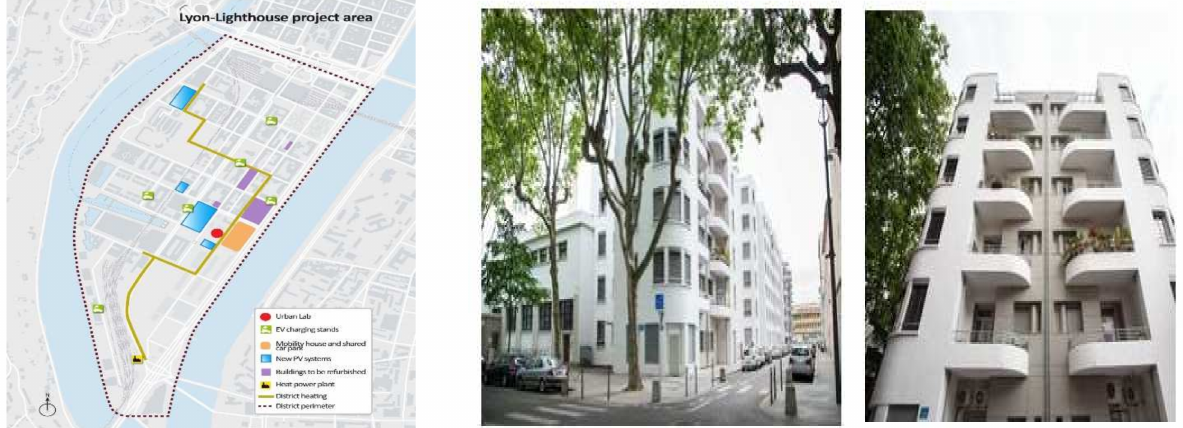
Figure 3. The Confluence district in Lyon ( left ) and Cit é Perrache building after refurbishment ( right ). © SPL Lyon Confluence